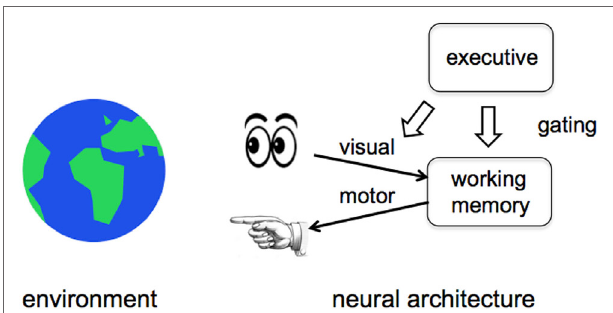
FigUre 3 | The top-level architecture of GALIS’ neural control system. The operational components of an intelligent agent’s control system, such as visual information processing, motor control, and working memory, are gated by an executive system at the upper right. Our work focuses on the top-down gated control of working memory in